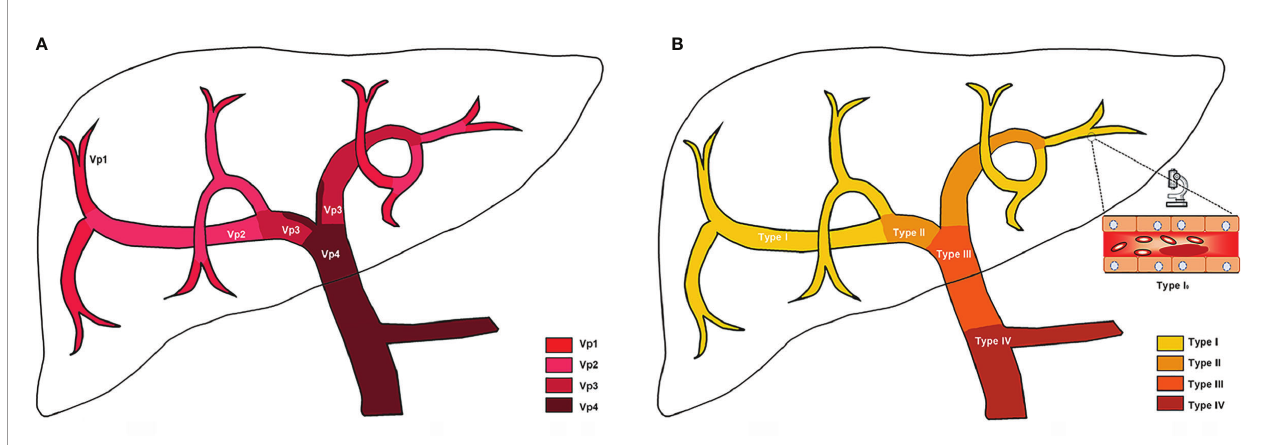
FIGURE 1 | Schematic of PVTT classi fi cations. (A) Japanese Vp classi fi cation; (B) Chinese Cheng ’ s classi fi cation. More details of classi fi cations have been listed in Table 1